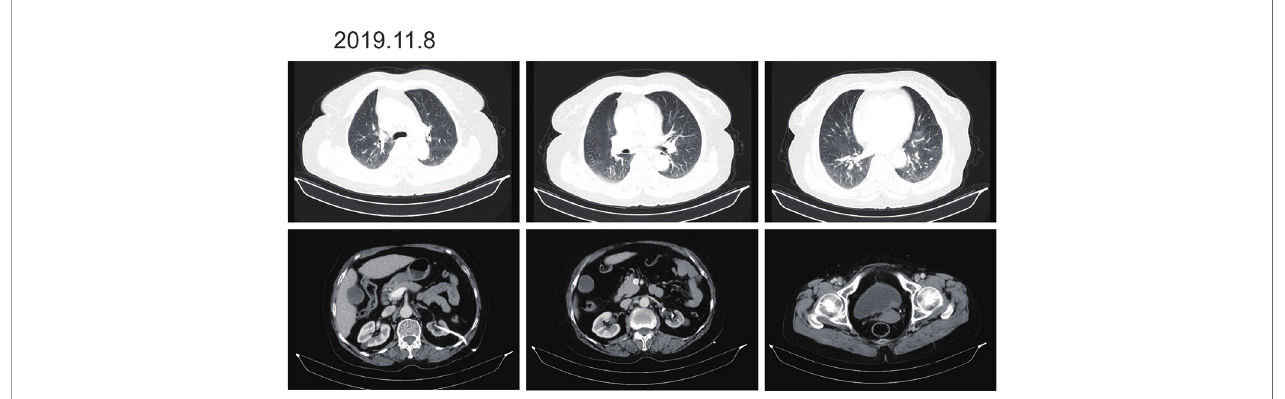
FIGURE 3 | Imaging after three cycles of Sintilimab immunotherapy. There are multiple round-shaped nodules in both lungs, with clear boundaries, and some are smaller than before. The local soft tissue shadow at the entrance of the ureter on the left side of the bladder thickens, forming soft tissue nodules, the size is about 24mm*10mm, which is smaller than before.